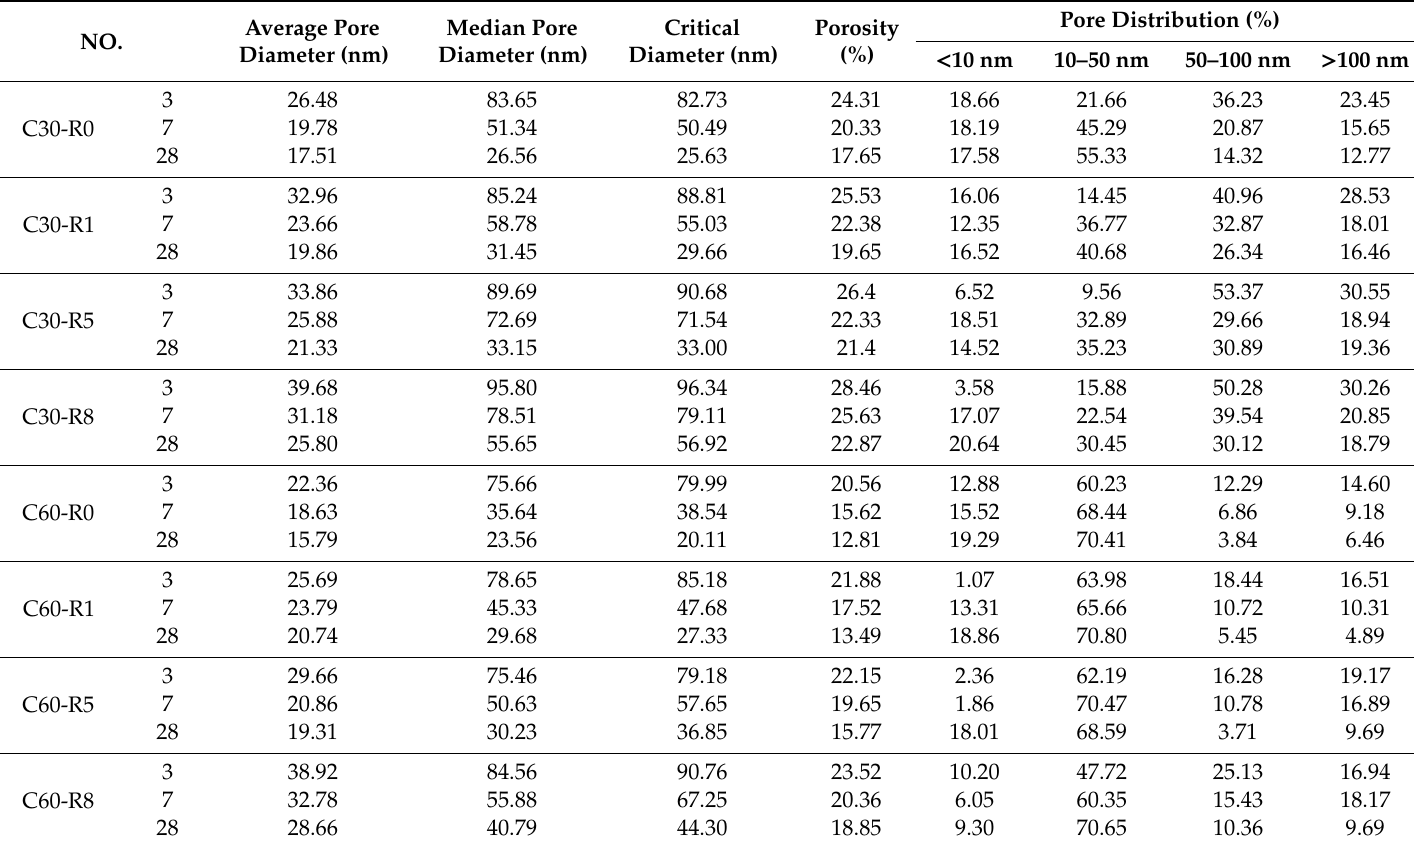
Table 5. Pore parameters of concrete at di ff erent